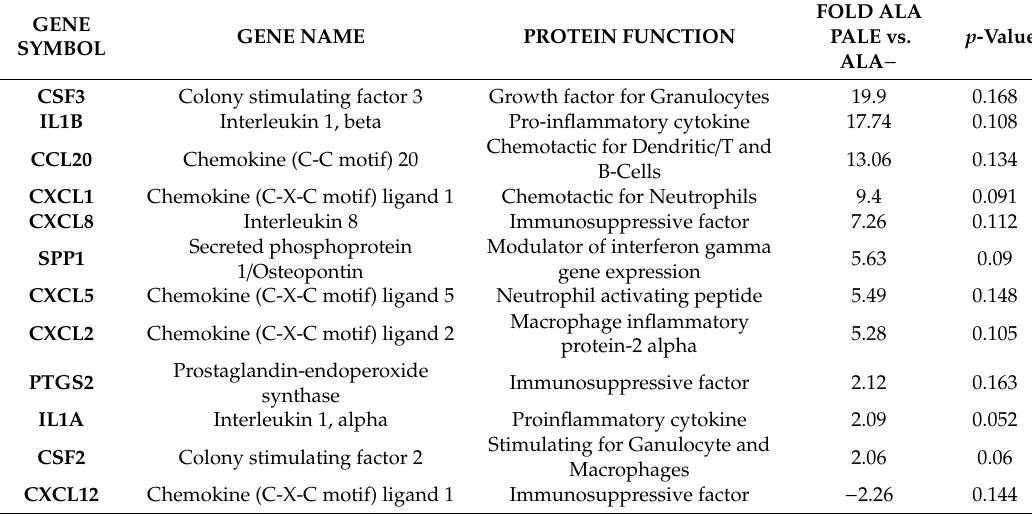
Table 4. Comparison of genes di ff erentially expressed in GASC-ALA PALE versus GASC-ALA − . Table shows genes with a significant up- or down-regulation, in GASC-ALA PALE compared to GASC-ALA − . Values indicate Fold Regulation calculated using the formula (2ˆ ( − Delta Delta CT)), i.e., the normalized gene expression (2ˆ ( − Delta CT)) in the test sample (GASC-ALA PALE) divided by the normalized gene expression (2ˆ ( − Delta CT)) in the control sample (GASC-ALA − ). p values are calculated based on a Student’s t-test of the replicate 2ˆ ( − Delta CT) values for each gene in control and treatment